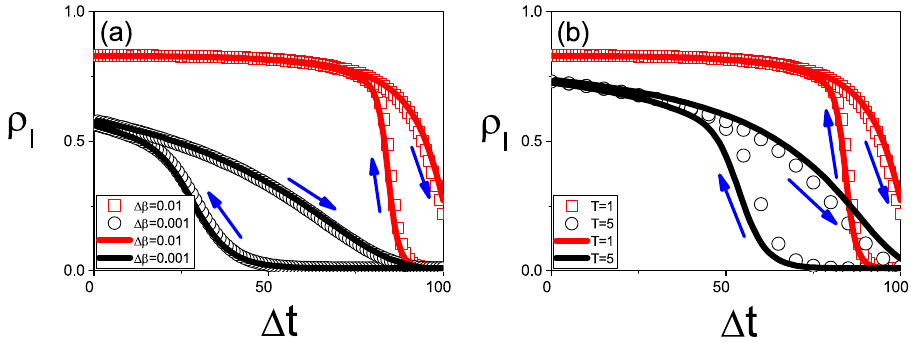
Figure 6. Consistence between the state and parameter spaces where the “squares” and “circles” in ( a ) and ( b ) come from Fig. 5(a) and (b) by Eq. (3), respectively, and the solid lines in ( a ) and ( b ) are the replotted Fig. 2(a) and (b),